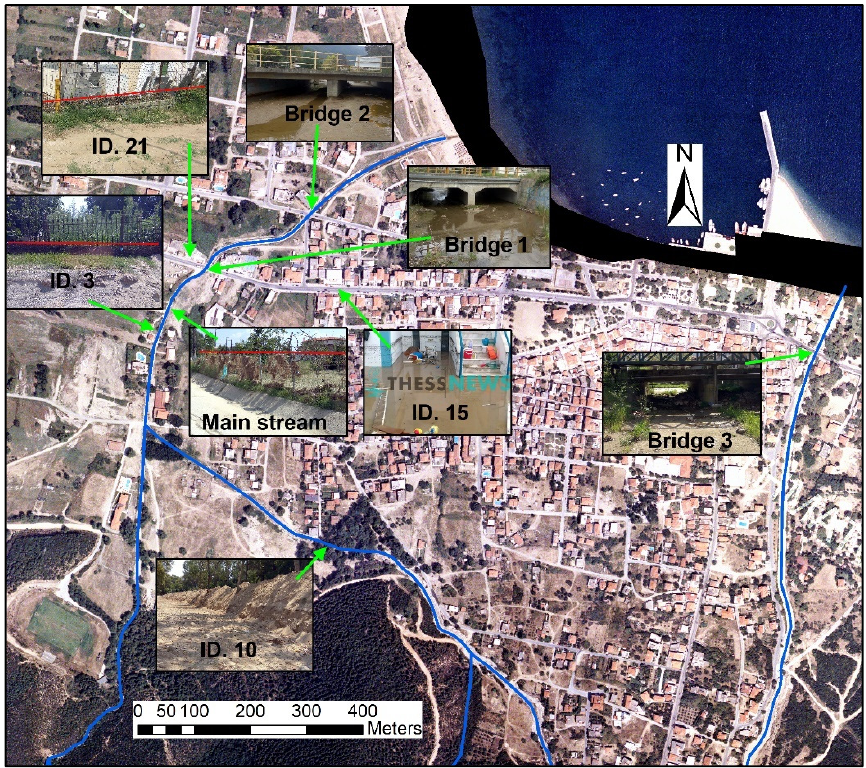
Figure 18. Display of flood marks and infrastructures that alter flow propagation.